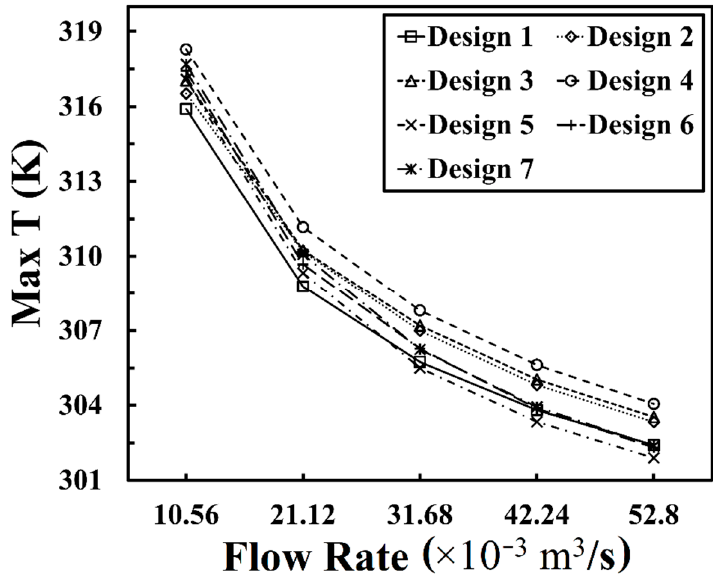
Figure 5. Maximum temperatures of 7 designs at 5 flow rates.